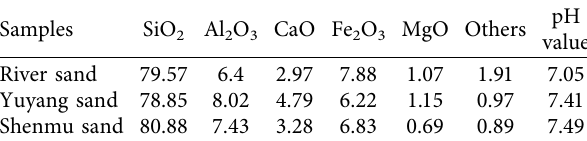
Table 2: Main chemical composition of the used sand.